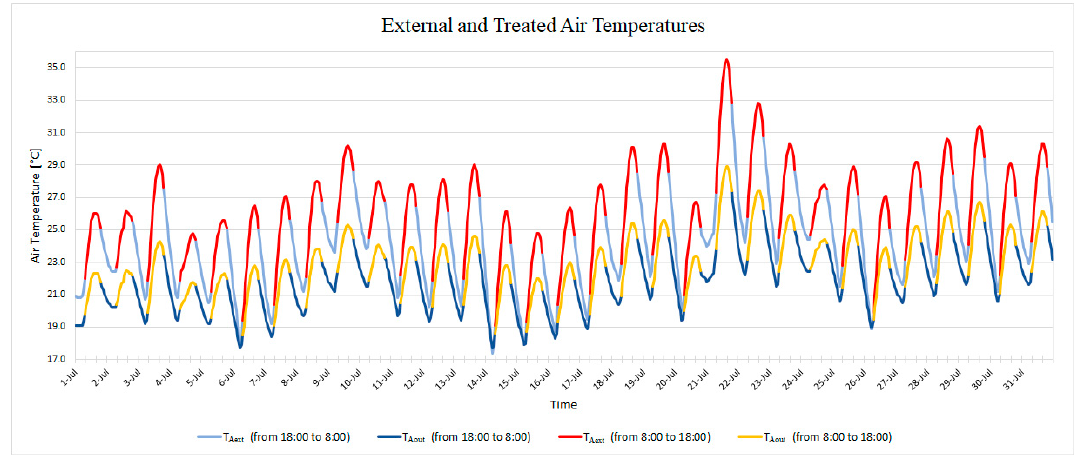
Figure 4. External and treated air temperatures during July, for the ACHP-HAGHE system and for the night free cooling.